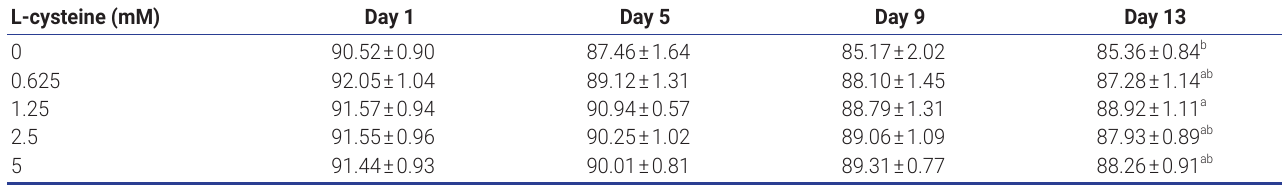
Table 1. Effects of different concentrations of cysteine on sperm total motility during the liquid storage L-cysteine (mM)